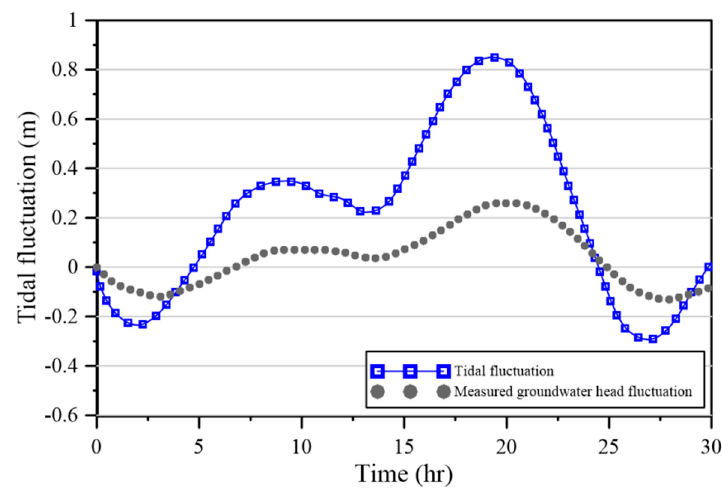
Figure 15. The location of Xing–Da port in southwestern Taiwan.